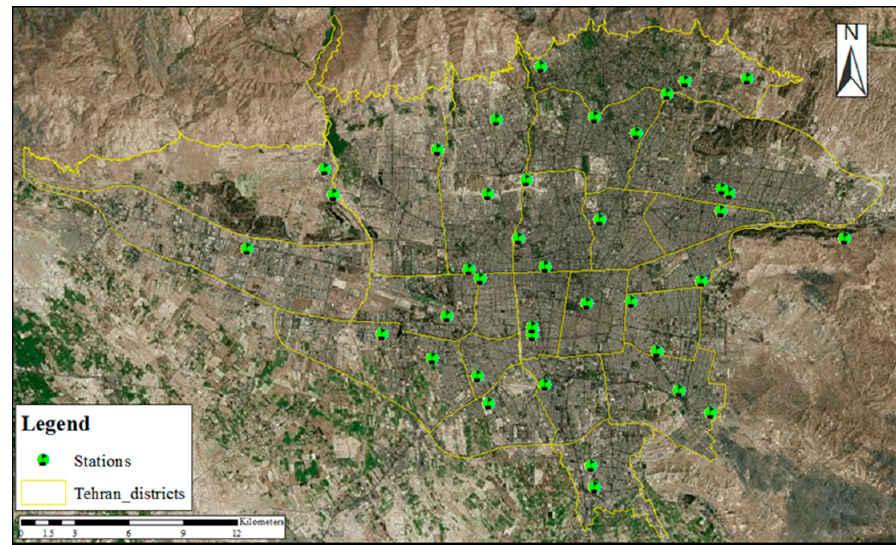
Figure 1. Tehran districts and air quality monitoring stations. Table 1. Statistical parameters for carbon monoxide (CO) and fine particulate matter (PM 2.5 ) in districts of Tehran.